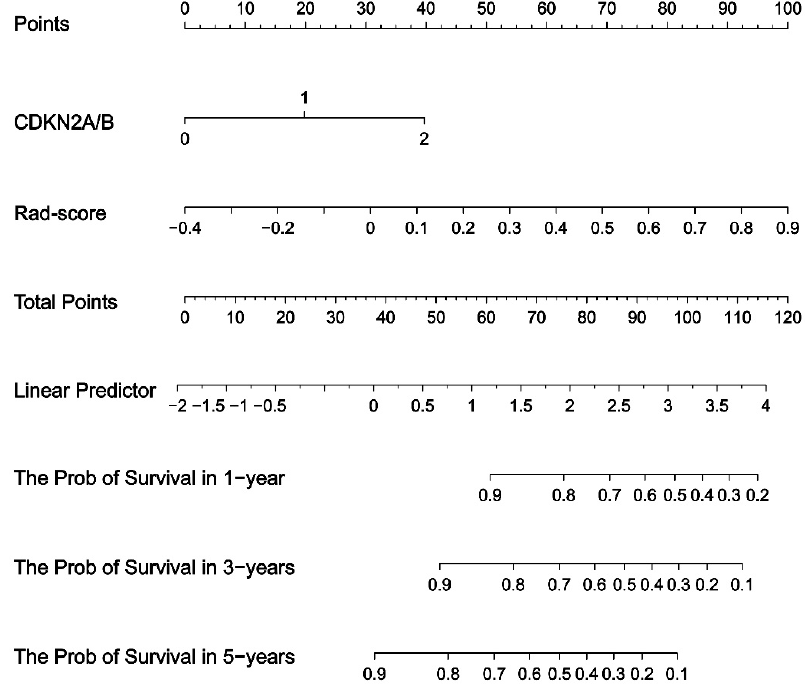
Figure 5. Nomogram of the training set of survival analysis: survival rate at 1-, 3-, and 5-years can be calculated from CDKN2A/B homozygous deletion status and rad-score.